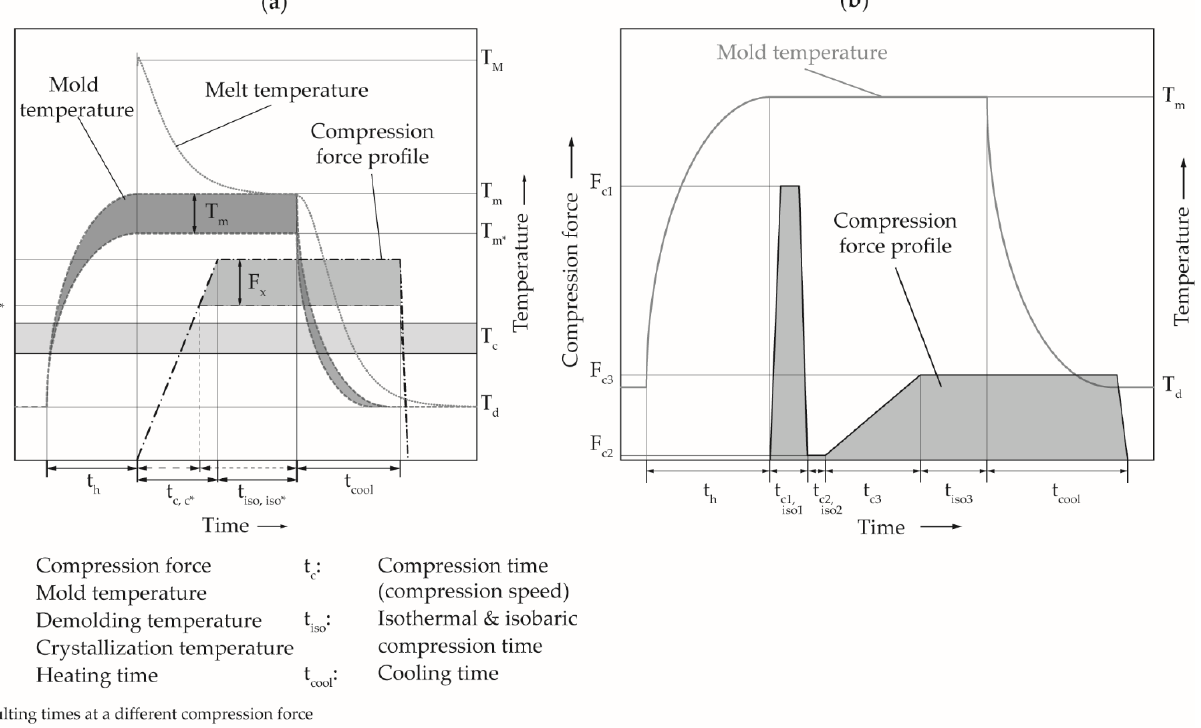
Figure 2. ( a ) Schematic process illustration of the production of the test specimens using ICM-DT; ( b ) schematic illustration of the multistage ICM-DT process.